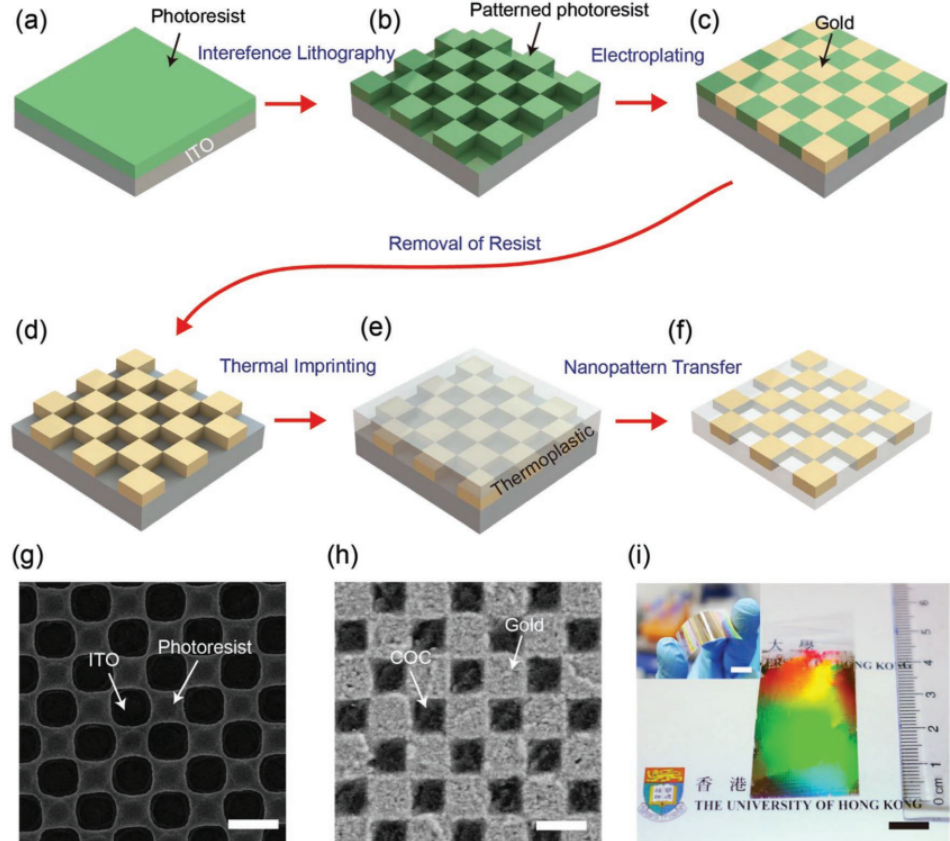
Figure 3. Plasmonic checkerboard structure and its fabricating process based on Holographic Lithography (HL). ( a – f ) The schematic diagram of manufacturing gold nanocheckerboard structure (ITO: indium tin oxide). ( g ) SEM image of the nanocheckerboard pattern prepared by HL on pho ‐ toresist. ( h ) SEM image of the nanocheckerboard structure inserted in a cyclic olefin copolymer (COC) film. ( i ) Photographs of the plasmonic film with gold nanocheckerboard metasurfaces. Re ‐ produced with permission from reference [39]. Copyright 2019 WILEY ‐ VCH Verlag GmbH & Co.